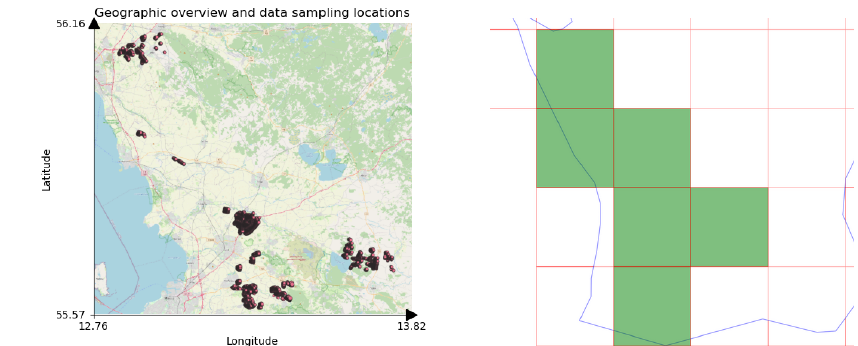
Figure 3. A geographical overview of the data. The left figure shows the locations of the fields in southwest Sweden. The figure to the right shows the same region where the green tiles represent the regions/patches of Sentinel-1 data downloaded. These patches were selected in order to cover all the fields.